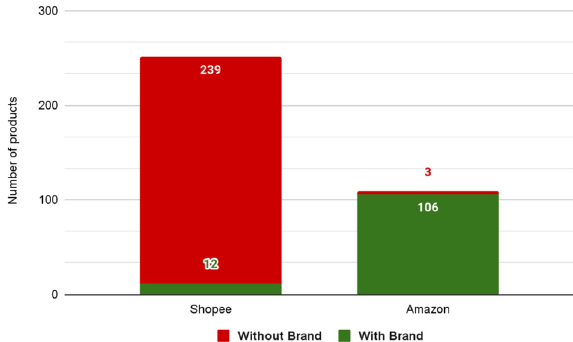
Figure 5. Brand identification between e-commerce